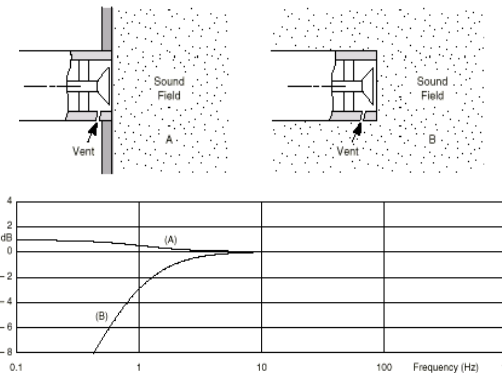
Fig. 13. Different sound exposure of microphones and related responses. Diaphragm only (left) gives upper response (A). Diaphragm and vent (right) gives lower response